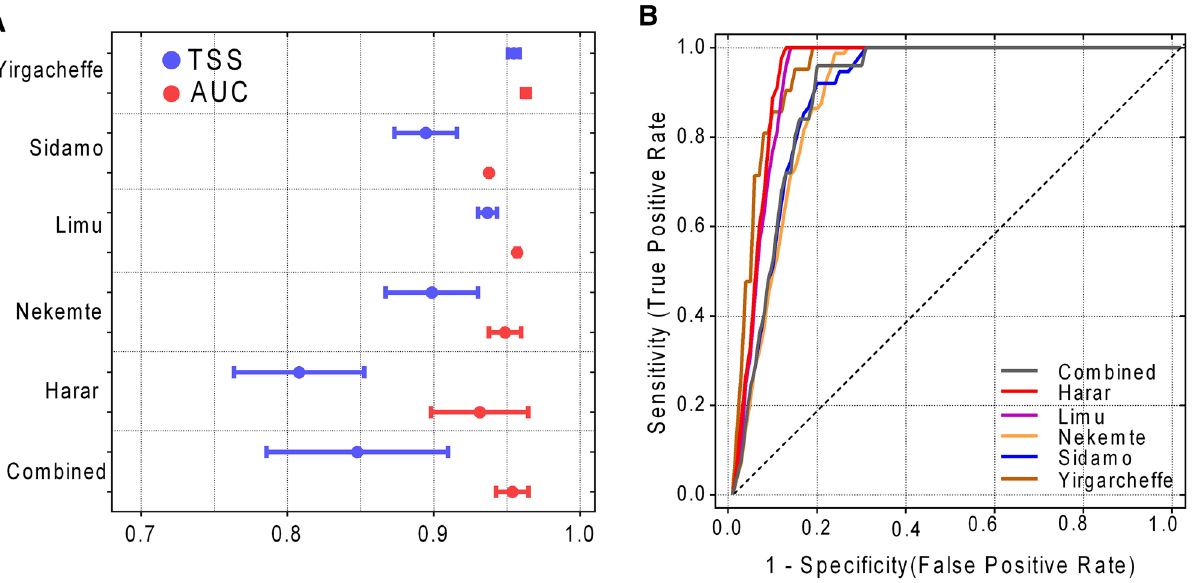
Figure 1. Performance evaluation of the individual models in the ensemble according to ( A ) TSS and AUC ( B ) ROC